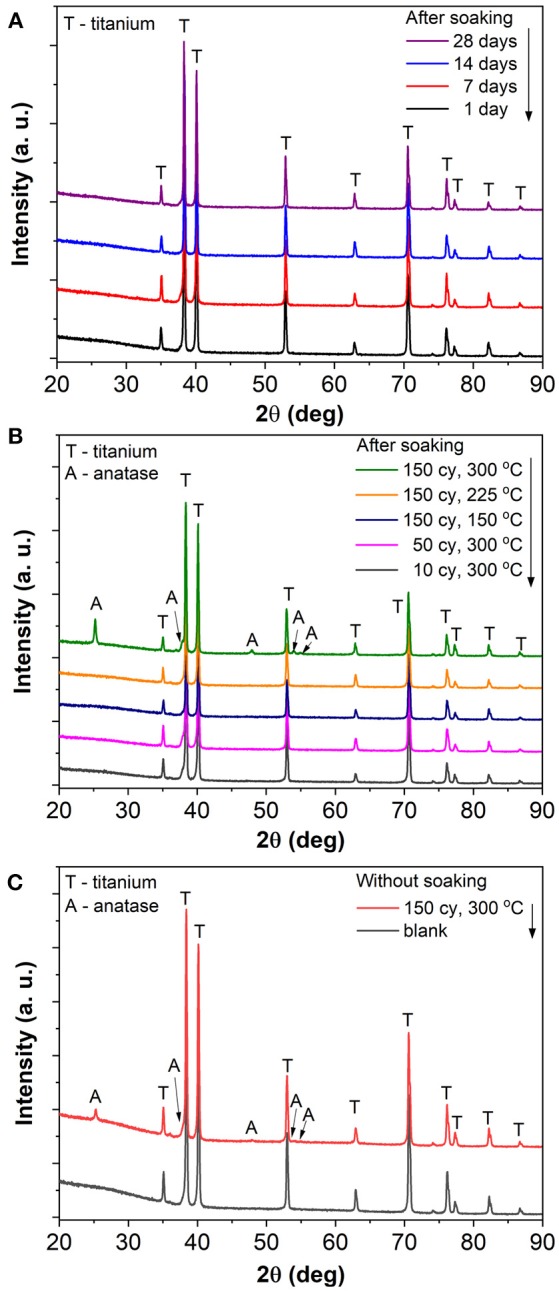
XRD patterns of (A) blank TiO2 nanotube layer soaked for 1, 7, 14, and 28 day(s), (B) TiO2 coated TiO2 nanotube layers with different coating thicknesses (NALD = 10, 50, 150) and different deposition temperatures (150°, 225°, and 300°C) soaked for 28 days, and (C) blank and TiO2 coated (NALD = 150 at 300°C) TiO2 nanotube layers (both without any soaking).